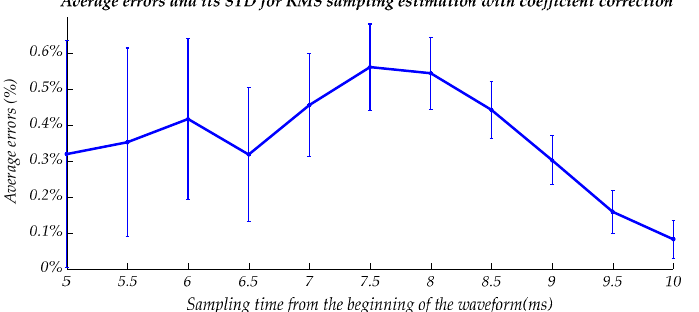
Figure 6. Estimation error of the method based on a sampling instantaneous voltage magnitude.